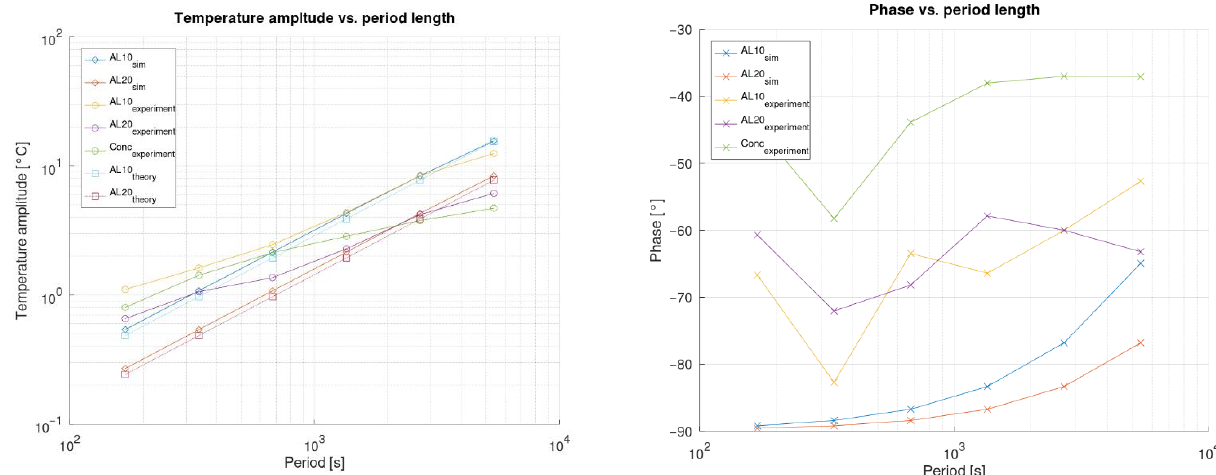
Figure 3. Amplitude and phase angle of the temperature signal from the thermal simulation and laboratory experiments and analytical solution. Depicted here are temperature amplitudes and phase angles calculated by the FFT in relation to excitation period. Note the theoretical phase angle for thermally thin and thick materials is −90° and −45° respectively.